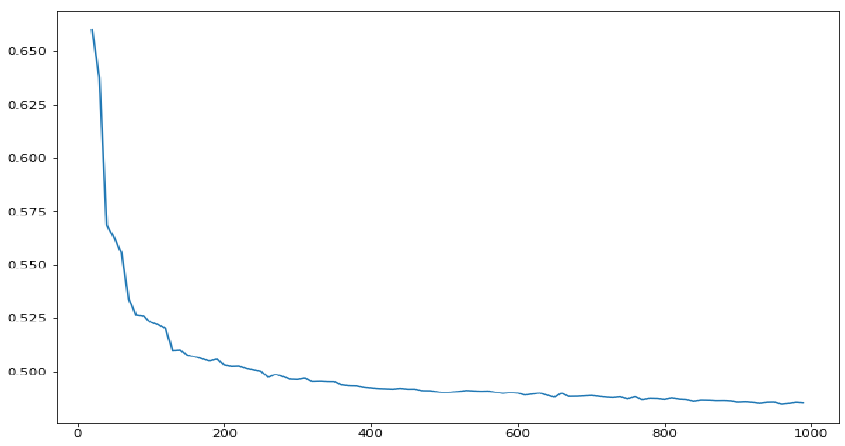
Figure 4. The 90th percentile, H lim ( n ) , of the Hurst exponents of the volatility series of Brownian motions for several values of the length of the series, n .